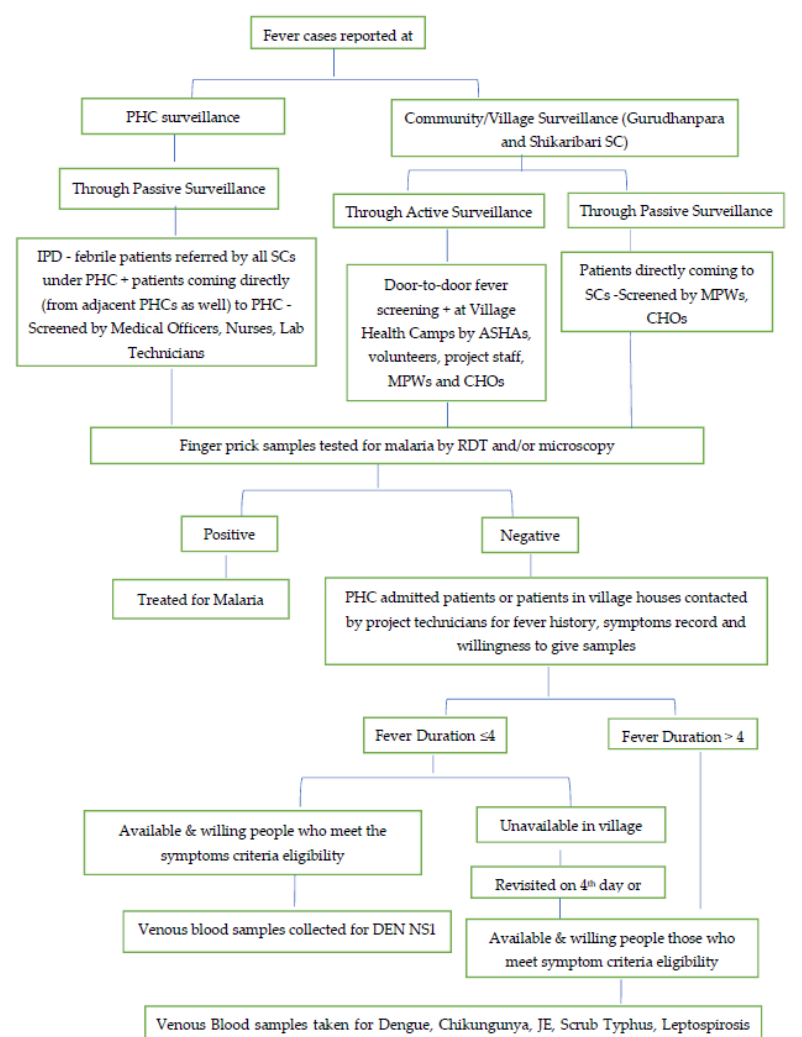
Figure 1. Flow chart of sample collection from Non-Malarial Febrile patients admitted in PHC and those identified by community/village surveillance: All febrile cases were diagnosed for malaria using RDT by ASHAs, village volunteers, project technicians at village household-based surveys, and MPWs or CHOs at SCs or during field-visits, and by microscopy/RDT by Laboratory Tech- nicians at PHC OPD or Nurses at IPD. Malaria-negative patients at PHC IPD or village house- holds were contacted for venous blood sample collection, as described in the flow chart, by the project lab technicians of ICMR-NE RMRC Dibrugarh. ASHA = Accredited Social Health Activists, RDT = Rapid Diagnostic Kit, MPW = Multipurpose workers, CHO = Community health Officers, OPD = Out Patient Department, IPD = Inpatient